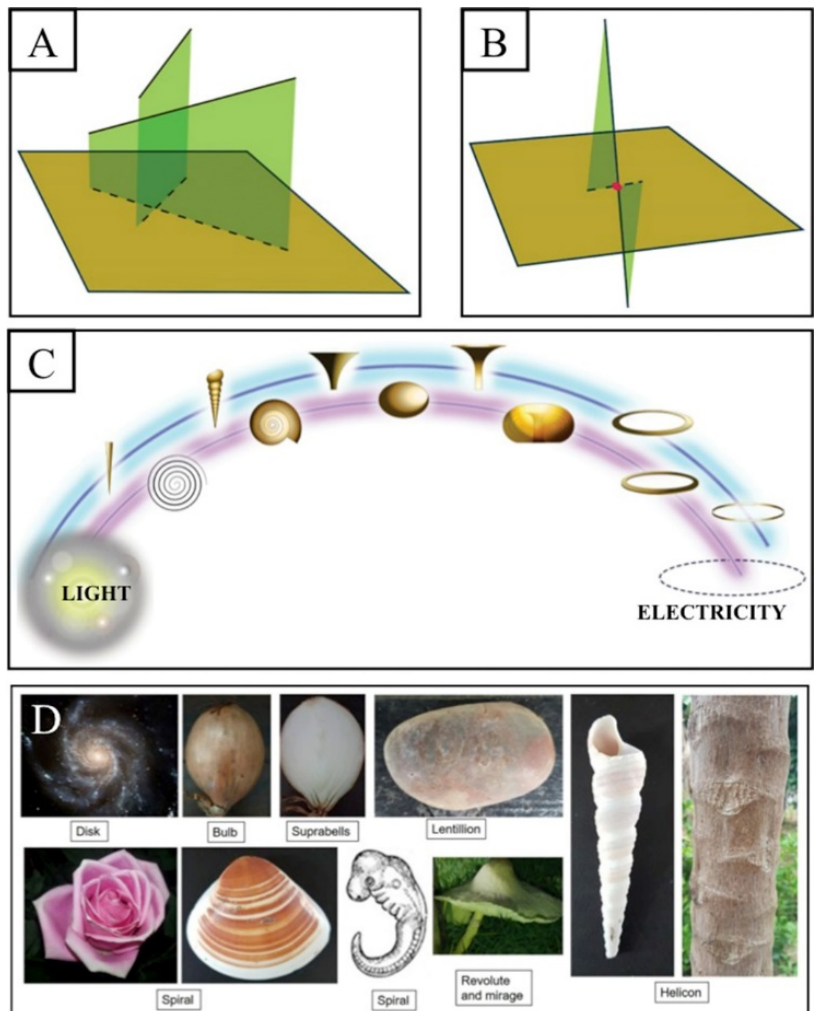
Figure 2. Limited projected waves and infinite shapes in the brain and nature. ( A ) Waves (green) in different dimensions. ( B ) Waves that really intersect our universe (a brown square) at the red point.